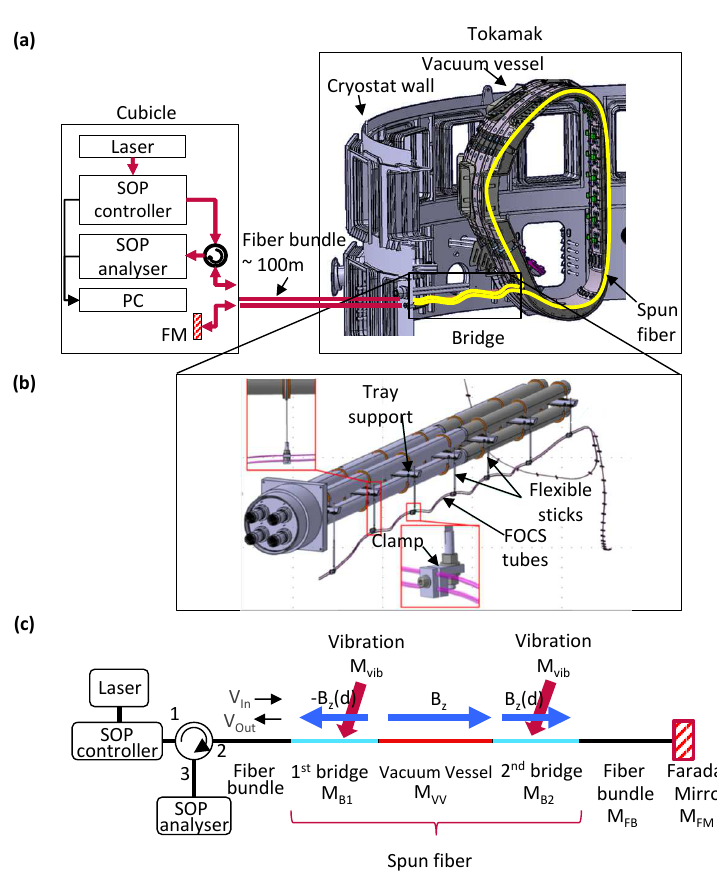
Figure 1. ( a ) FOCS configuration in the ITER. ( b ) Bridge structure inside the tokamak area and design of the FOCS tube [14]. ( c ) Block diagram of FOCS with bridge vibration. ©2023 the ITER Organization. This image is hereby used courtesy of the ITER